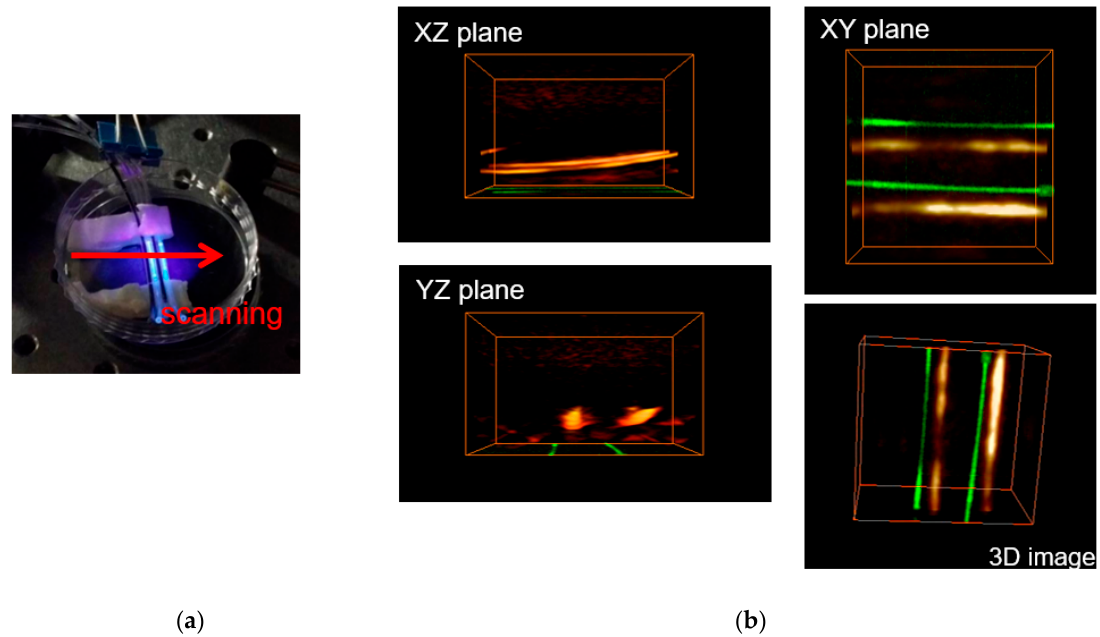
Figure 10. ( a ) Photograph of the sample. Two tubes are filled with black ink and two are filled with fluorescence particles; red arrow indicates the scanning direction. ( b ) Three-dimensional photoacoustic image and two-dimensional projected fluorescence image. Photoacoustic image (orange) and fluorescence image (green) along the XZ, XY, and YZ planes.